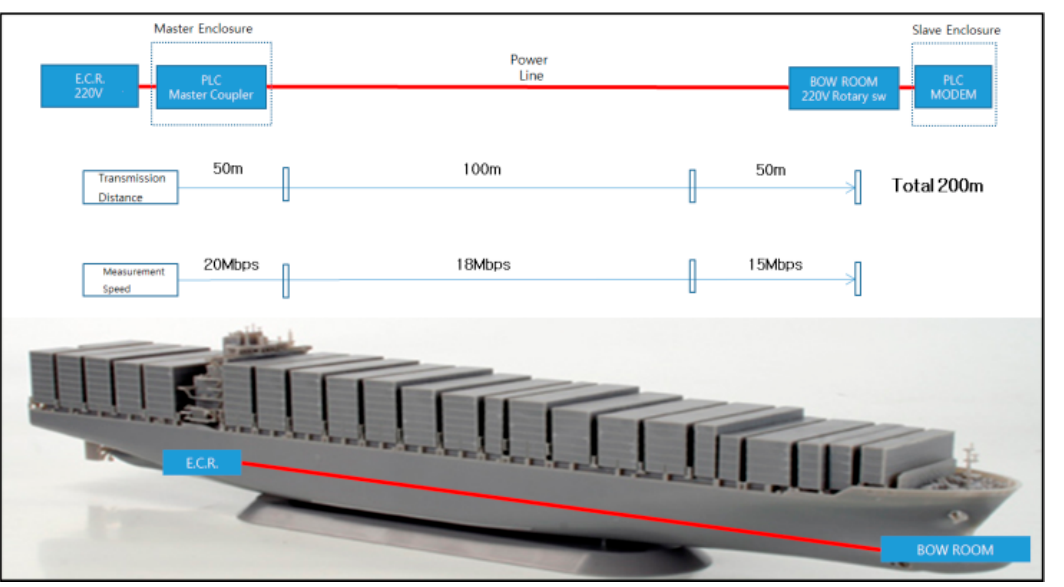
Figure 18 . Data quality test using PLC-based TCP/IP communication. Figure 18. Data quality test using PLC-based TCP/IP